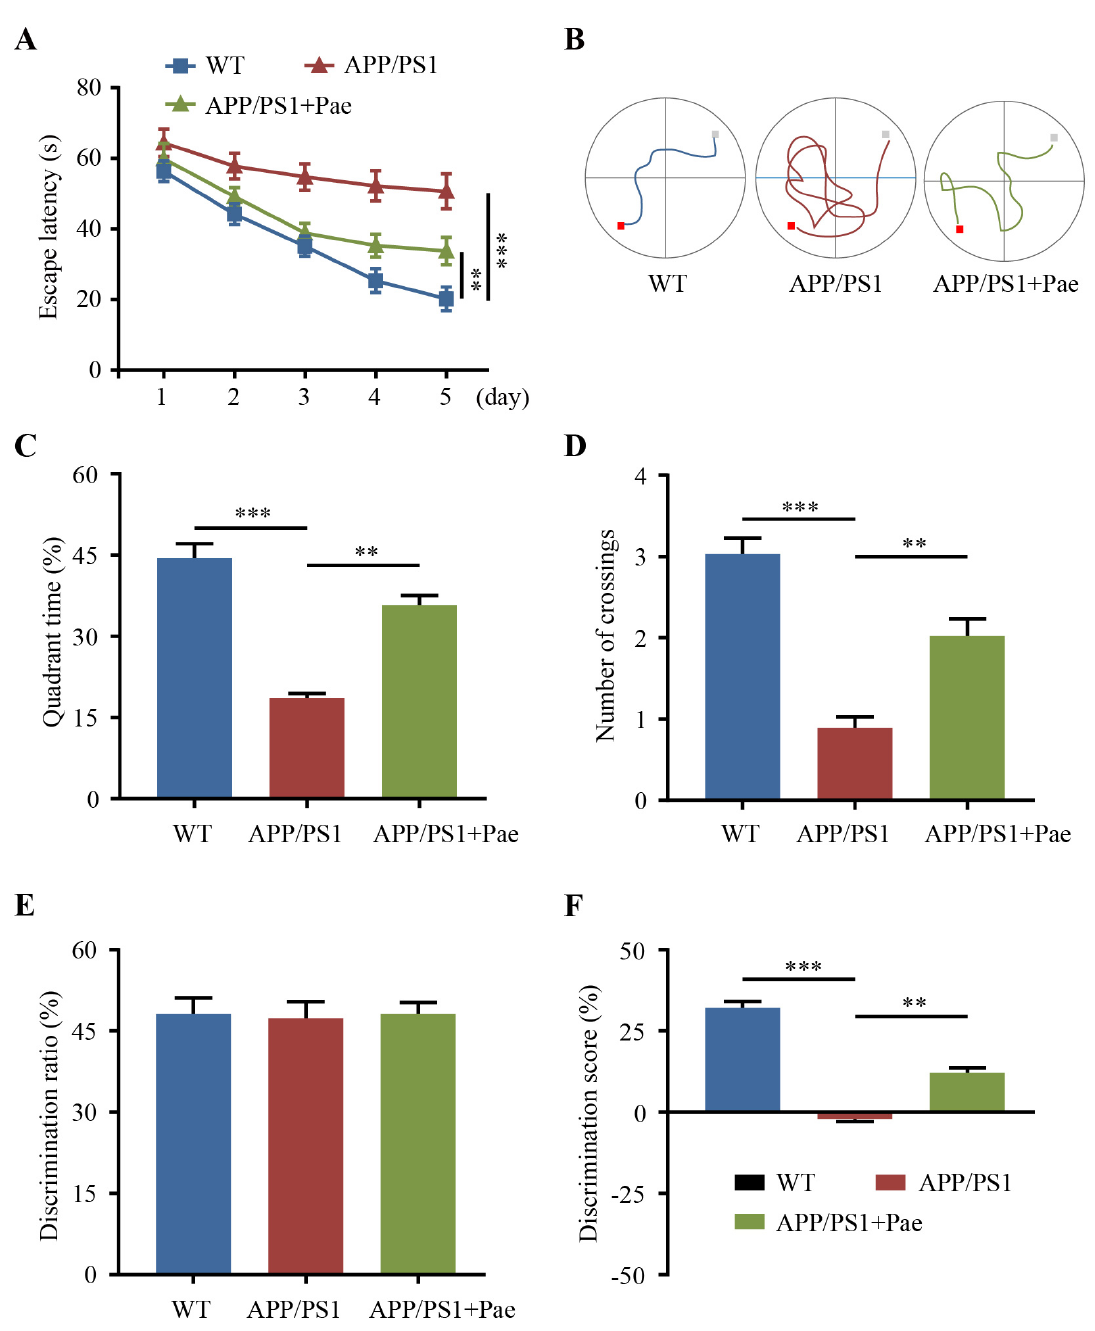
Fig. 1. Paeonol improves neurobehavioral outcomes in APP/PS1 transgenic mice. (A) The time to climb on the hidden platform during the training phase of Morris water maze. (B) Trace map of the mice during the Morris water maze test. (C) The time of exploring hidden platform in the Morris water maze. (D) The number of crossing hidden platform in the Morris water maze. (E) Time of exploring same object in the novel object test. (F) Recognition index performance in the novel object test. Mean ± SEM was shown (n = 8). ** p < 0.01, *** p <